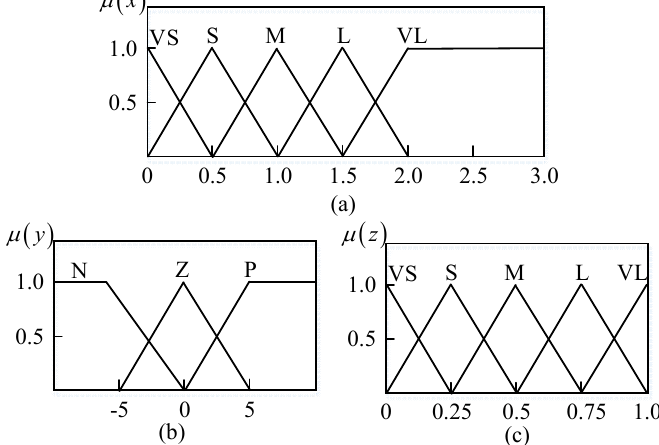
Figure 9. Block diagram of the fuzzy logic control.